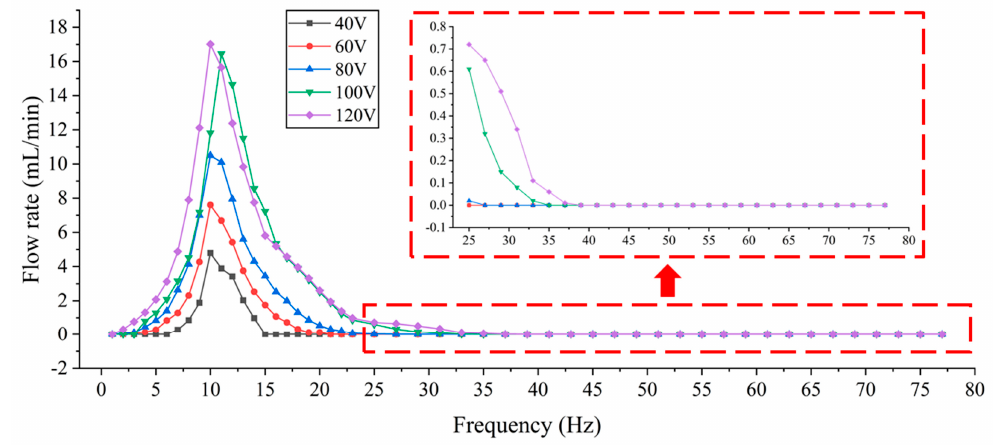
Figure 12. The flow rate results of the pump.